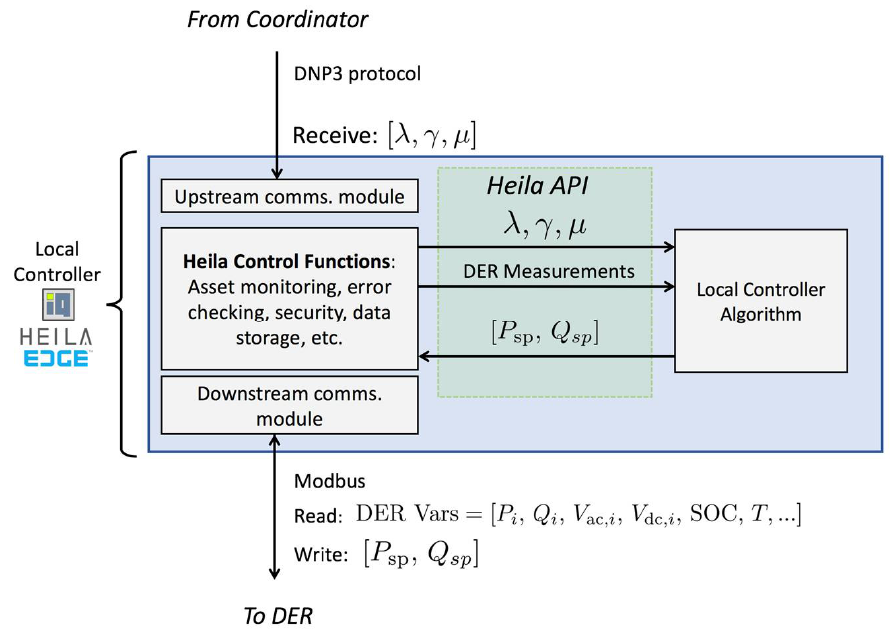
Figure 6. Illustration of the Heila local controller implementation.